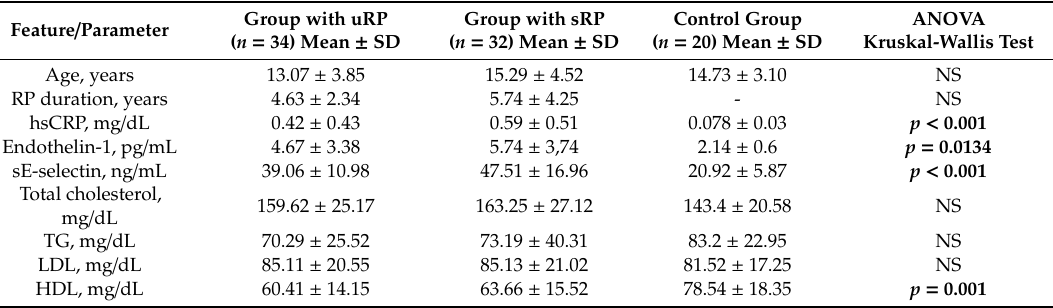
Table 6. Concentrations of the selected endothelial dysfunction markers and lipid metabolism parameters in the patients with undi ff erentiated (uRP) and secondary Raynaud’s phenomenon (sRP) compared with the control